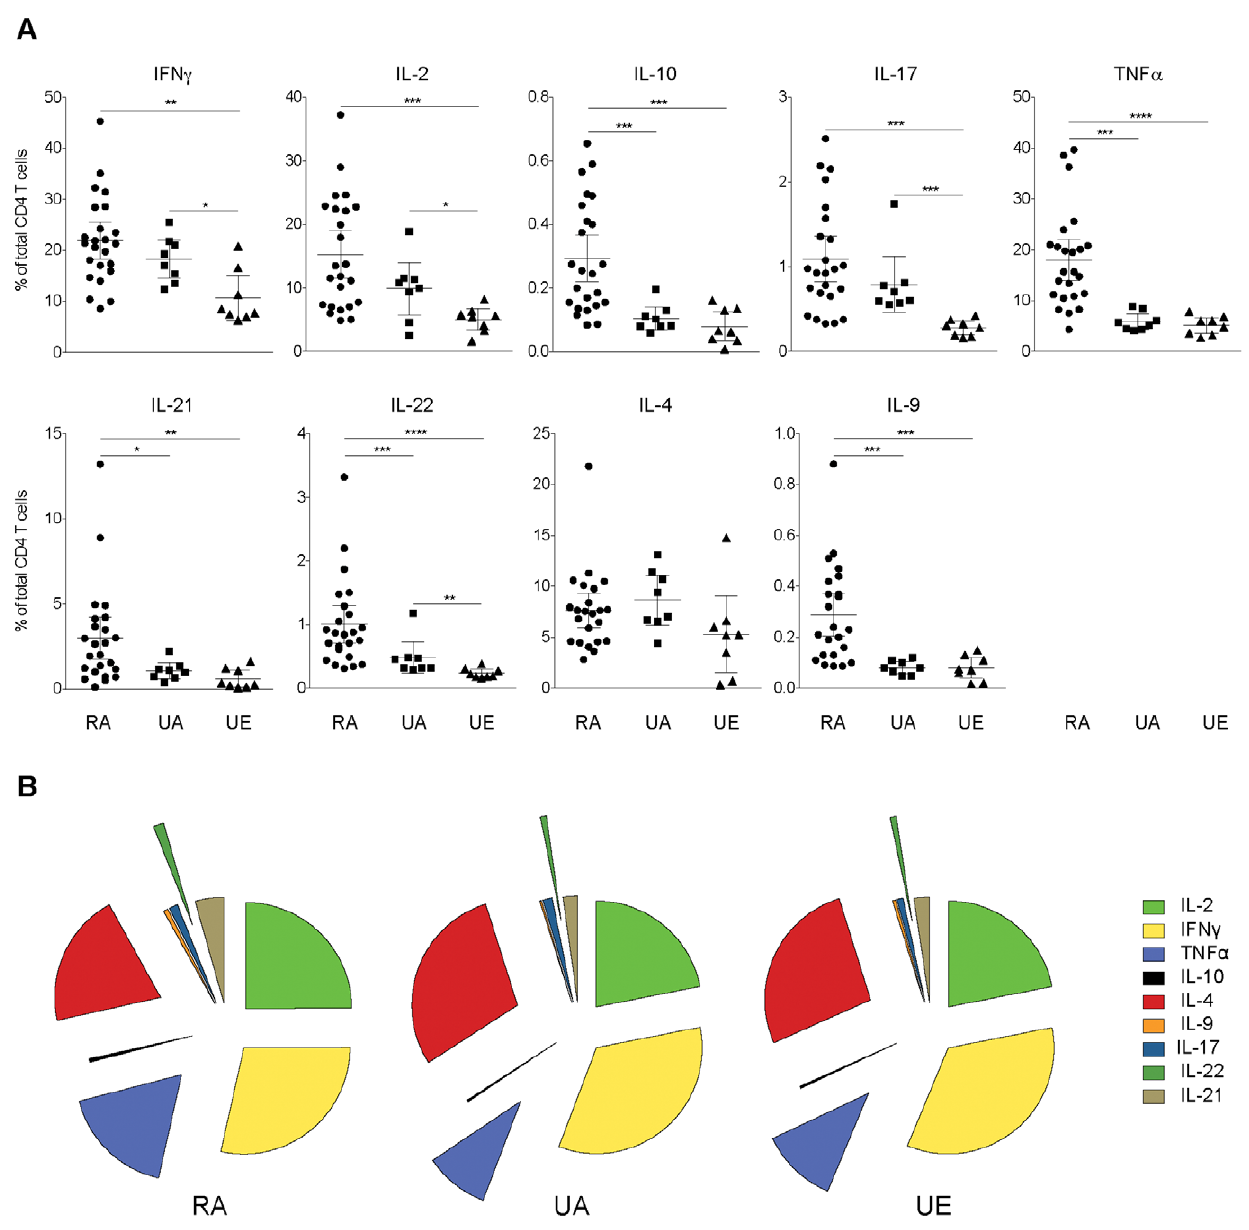
Figure 3. Functional analysis of CD4 T cell cytokine response in the three groups of donors. (A) The frequency of CD4 T cells positive for each cytokine (IFN c , IL-2, IL-10, IL-17, TNF a , IL-21, IL-22, IL-4 and IL-9, respectively) is represented as a percentage of CD4 T cells (mean (%) and 95% confidence intervals are indicated) and compared between the 3 groups of donors (rural African donors, RA, n=25; urban African donors, UA, n=8; urban European donors, UE, n=8). Nonparametric Mann-Whitney U test was used to analyse differences in the T cell responses between groups. An Asterisk indicates statistically significant P -values ( , 0.05) (*P , 0.05; **P # 0.01; ***P # 0.001). The pie charts in B show the relative frequency of the different cytokine responses within the overall cytokine producing CD4 T cell population. The mean frequency of CD4 T cells positive for each cytokine is represented as a fraction of the total cytokine response by CD4 T cells (%) and compared between the 3 groups of donors (RA, n=25; UA, n=8; UE,